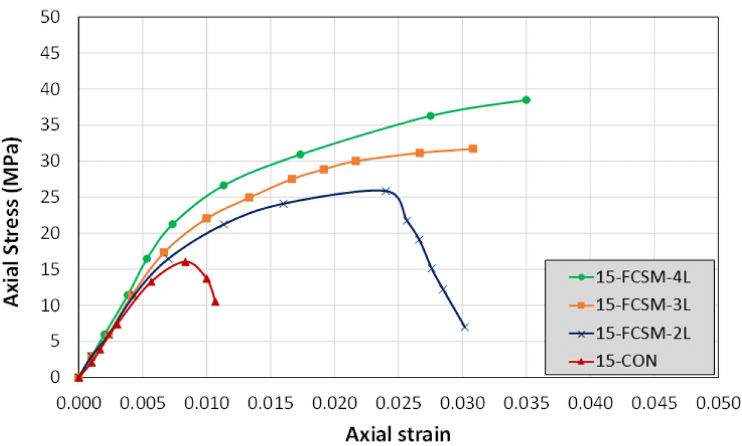
Figure 7. Compressive stress-strain curves of group 1 specimens.